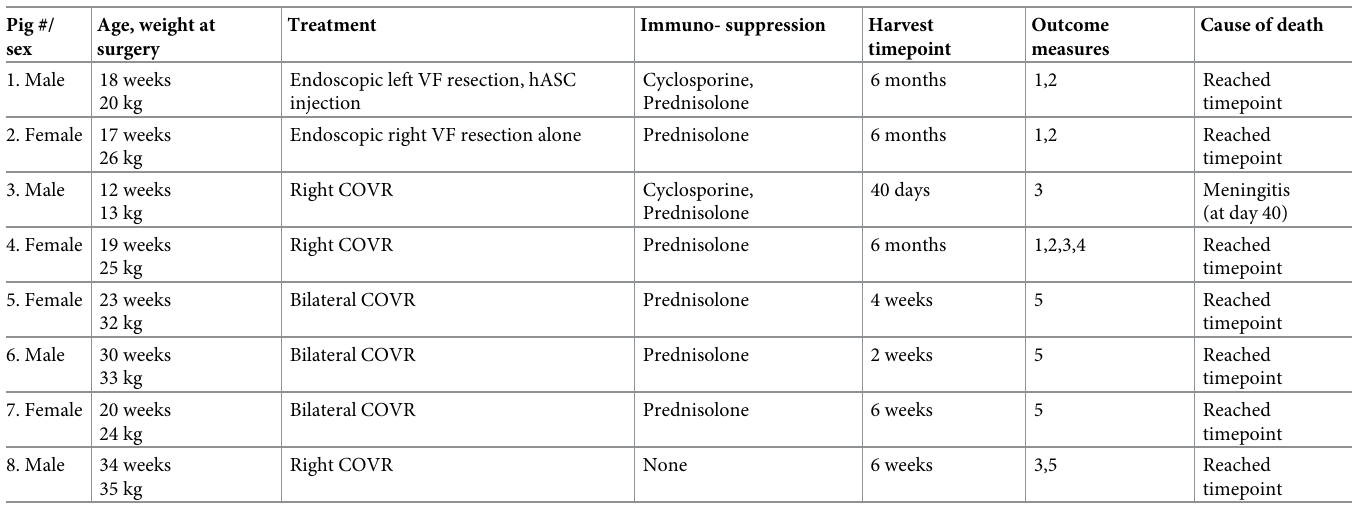
Table 1. Chronology of pigs used during pilot studies. Pig #/ Age, weight at sex